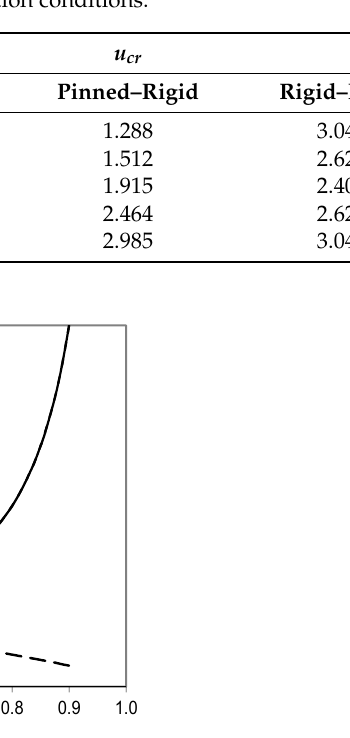
Table 1. Values of u cr for the investigated end connection conditions.